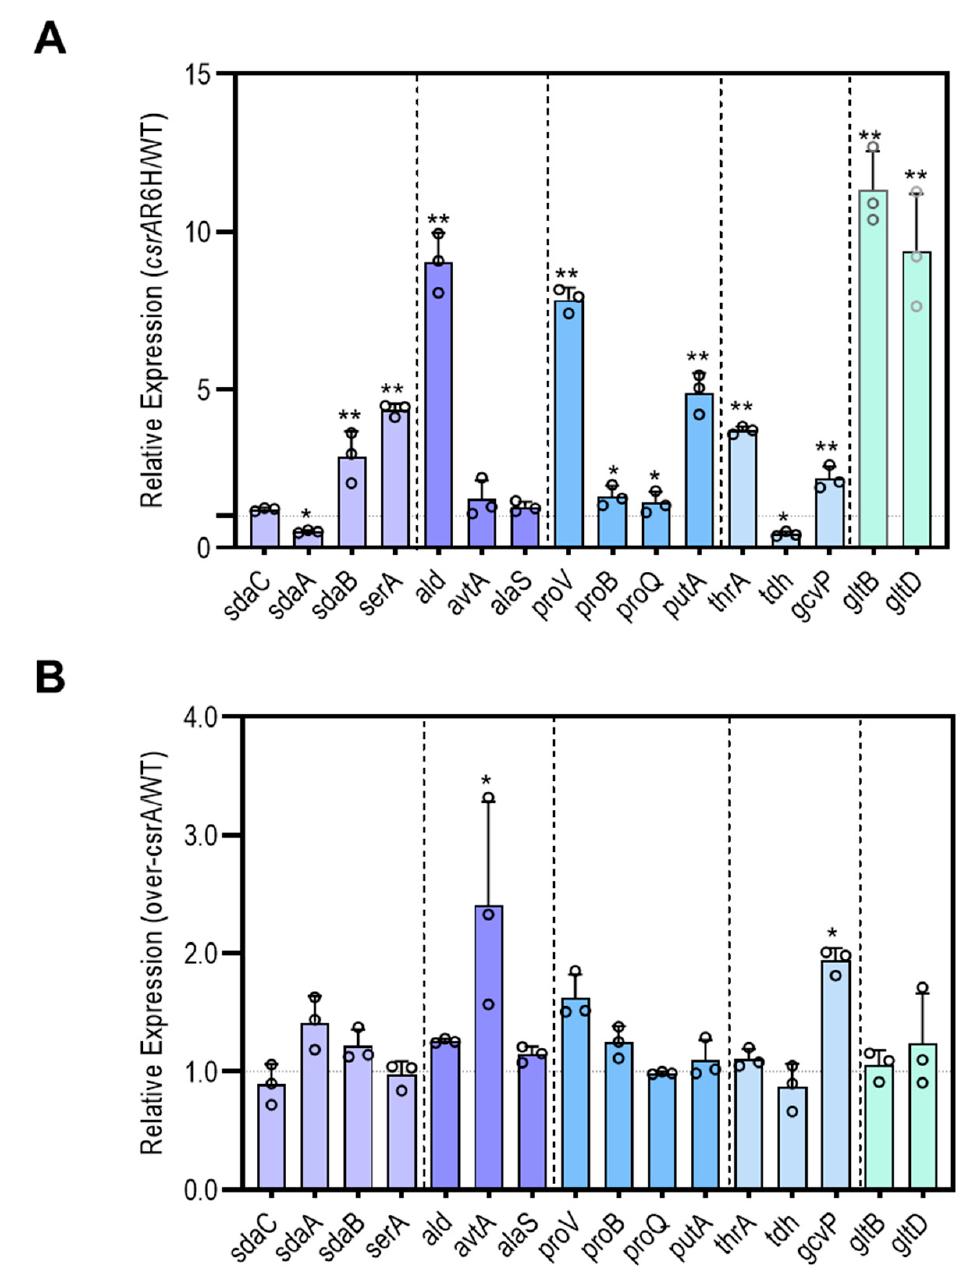
Figure 5. CsrA affects the expression of genes related to amino acid metabolism. The color code matches the genes involved in amino acid metabolism, serine metabolism ( serA, sdaC , sdaB , sdaA ), alanine metabolism ( ald , avtA , alaS ), proline metabolism ( proV , proQ , proB , putA ), threonine ( thrA , tdh , gcvP ), and glutamine metabolism ( gltD , gltB ). ( A ) The relative expression of the csrA .R6H strain divided by that of the WT. ( B ) The relative expression of the over- csrA strain divided by that of the WT. Data are presented as the mean ± SD. * p < 0.05, ** p < 0.01 by one-way ANOVA with the FDR post hoc test, comparing the ZJ_T- csrA R6H and overexpression strain to the wild